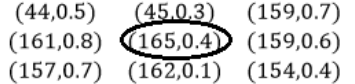
Figure 1. The 3 × 3 neighborhood for